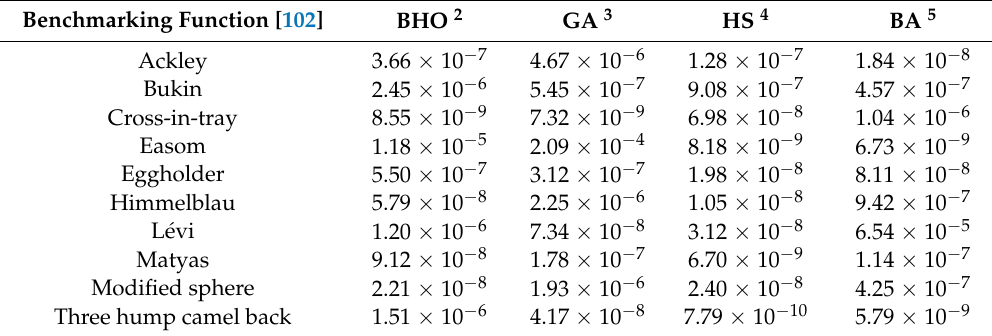
Table 1. Error values of bat algorithm (BA) and other three heuristic algorithms 1